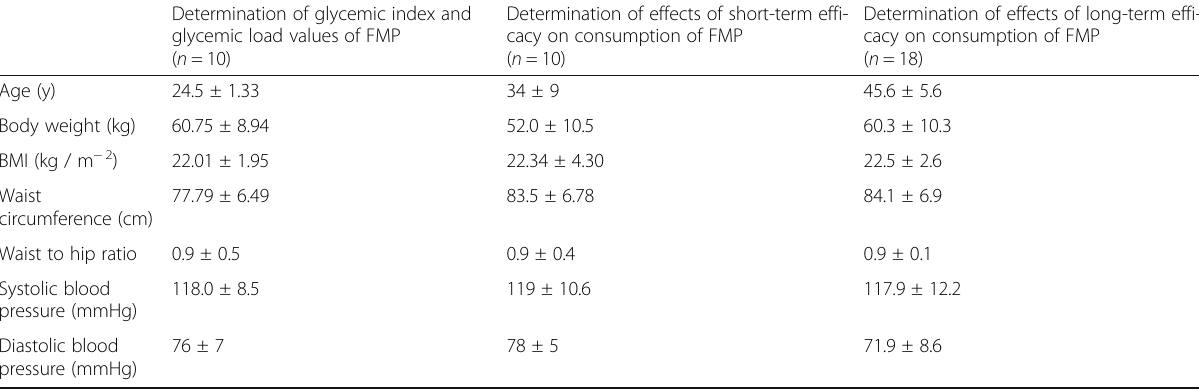
Table 1 General information about participants involved in different studies Determination of effects of short-term effi- Determination of glycemic index and glycemic load values of FMP cacy on consumption of FMP